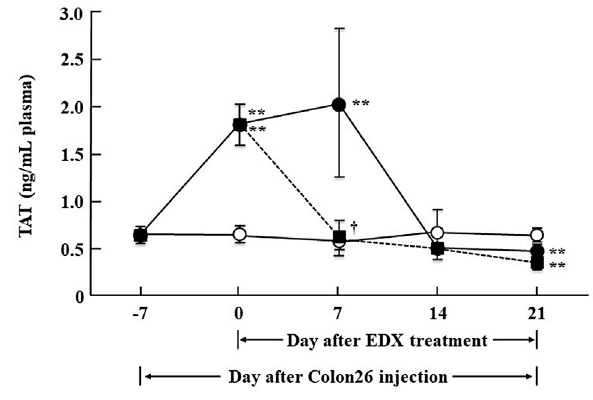
Fig. 7 Effect of edoxaban (EDX) on plasma thrombin-antithrombin complex (TAT) levels in untreated (UTR) control mice and Colon26- inoculated mice. Seven days (day 0) after inoculating mice with Colon26 cells, water or EDX (10mg/kg/d) was orally administered daily for 21 days; citrated plasma samples were prepared from blood drawn from the heart on days -7, 0, 7, 14, and 21 of UTR mice ( n ¼ 5) ( ○ ), water-treated group ( n ¼ 5) ( ● ), or EDX-treated group ( n ¼ 5) ( & ) of Colon26-inoculated mice. Plasma TAT concentration was deter- mined by ELISA. Signi fi cant differences in plasma TAT levels between the water-treated group or EDX-treated group of Colon26-inoculated mice and the UTR mouse group are shown as (cid:5)(cid:5) p < 0.01. Signi fi cant differences in plasma TAT levels between the water-treated group and EDX-treated group of Colon26-inoculated mice are shown as † p <